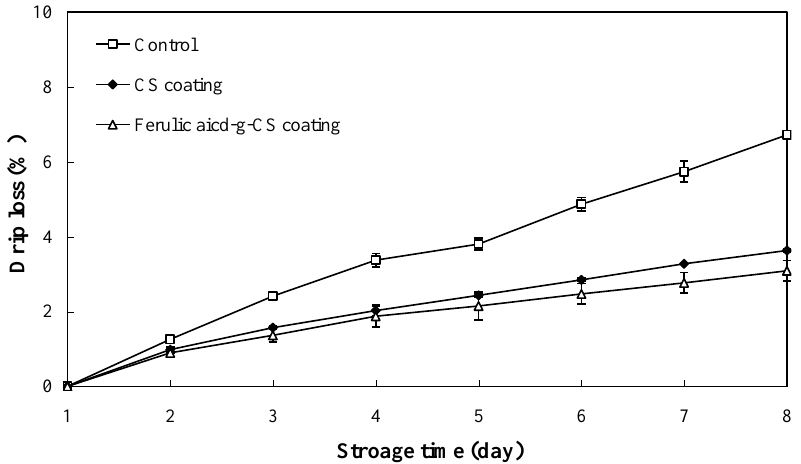
Figure 5. Changes in the drip loss of pork in the control group, CS coating group and ferulic acid-g-CS coating group at 4 °C for 8 days. Data are presented as means ± SD of triplicates.